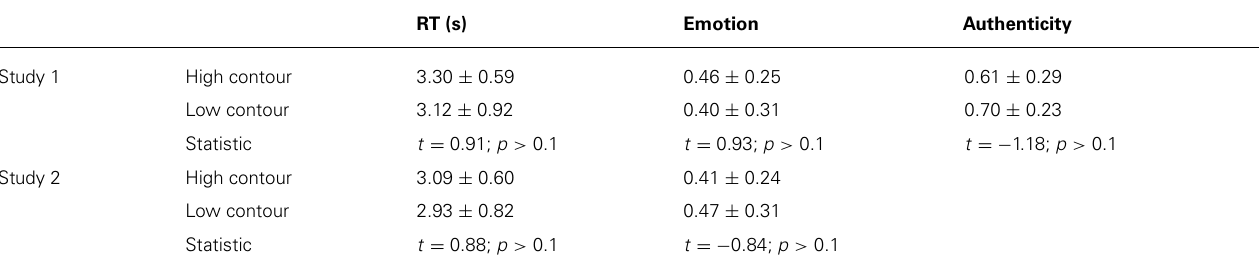
Table 2 | Mean values of high and low stimulus groups by F0 contour (SD).